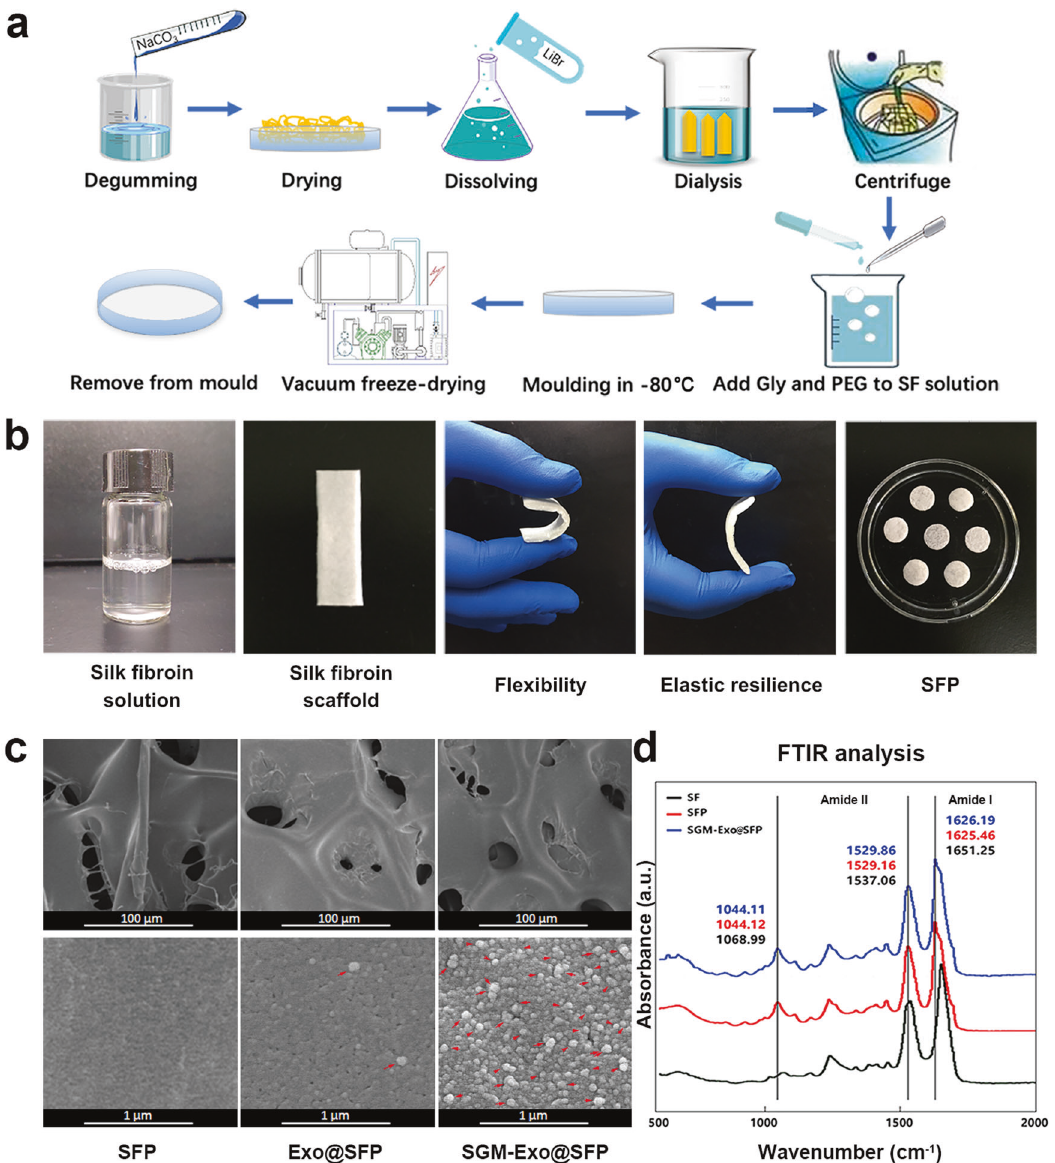
Fig. 2 The preparation and characterization of the silk fi broin patch (SFP) served as exosome-laden scaffolds. a Schematic illustration of the preparation procedure for SF scaffolds. b Physical pictures of silk fi broin solution, SF scaffold, and SFP. c The structure characterizations of SFP, Exo@SFP, and SGM-Exo@SFP detected by scanning electron microscope (upper scale bars: 100 μ m, lower scale bars: 1 μ m). The red arrows indicated the exosomes loaded on the SFP. d FTIR spectra analysis of SF, SFP, and SGM-Exo@SFP ( n =